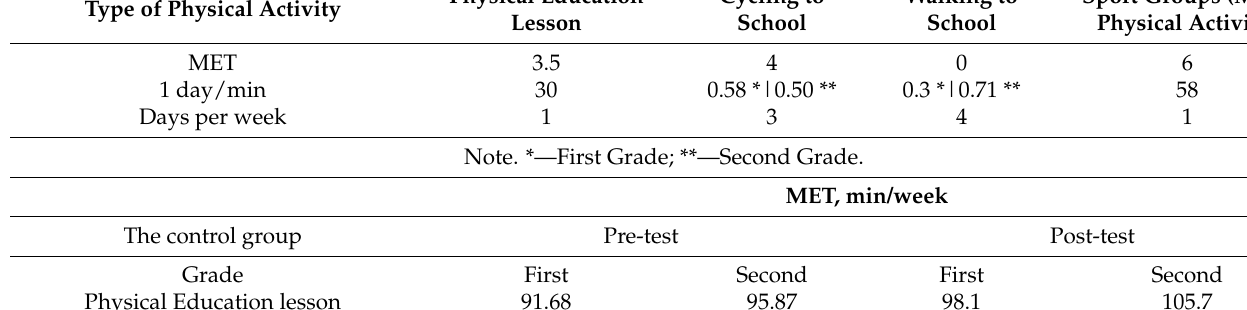
Table 4. The physical activity level using the MET method (the pre-test/post-test results of the control group). Physical Type of Physical Activity